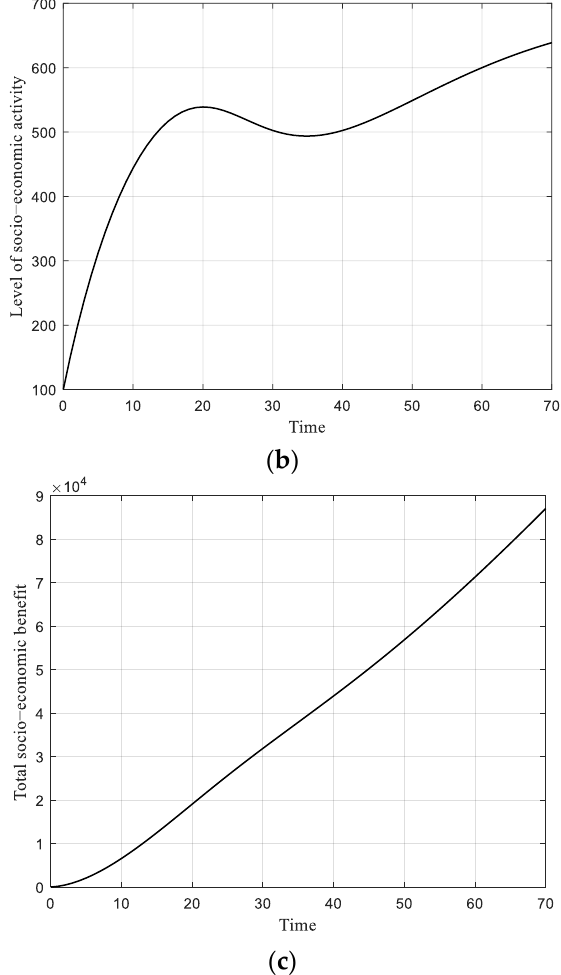
Figure 4. Results of static strategy with low strength of epidemic prevention and control measures. ( a ) Total socio-economic benefit versus strength of economic stimulus measures, with a low strength of pandemic prevention and control measures ( 𝐸 𝑝 = 3). ( b ) Level of socio-economic activ- ity, along with time when 𝐸 𝑝 = 3 and 𝐸 𝑠 = 50. ( c ) Total socio-economic benefit, along with time when 𝐸 𝑝 = 3 and 𝐸 𝑠 = 50.